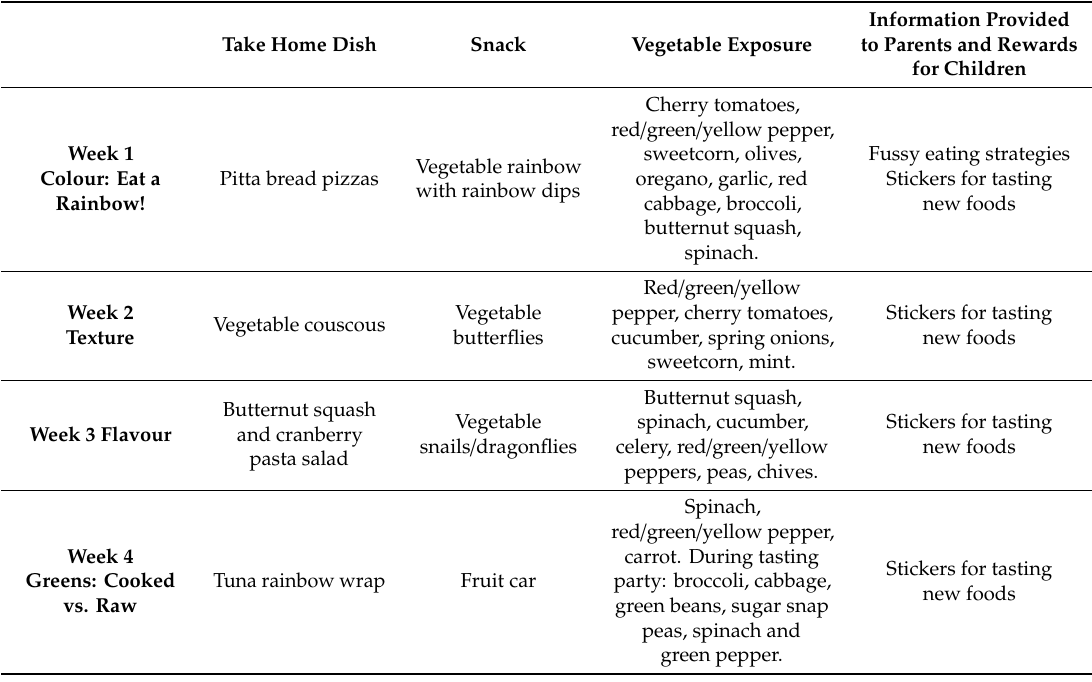
Table 1. BCLC Weekly